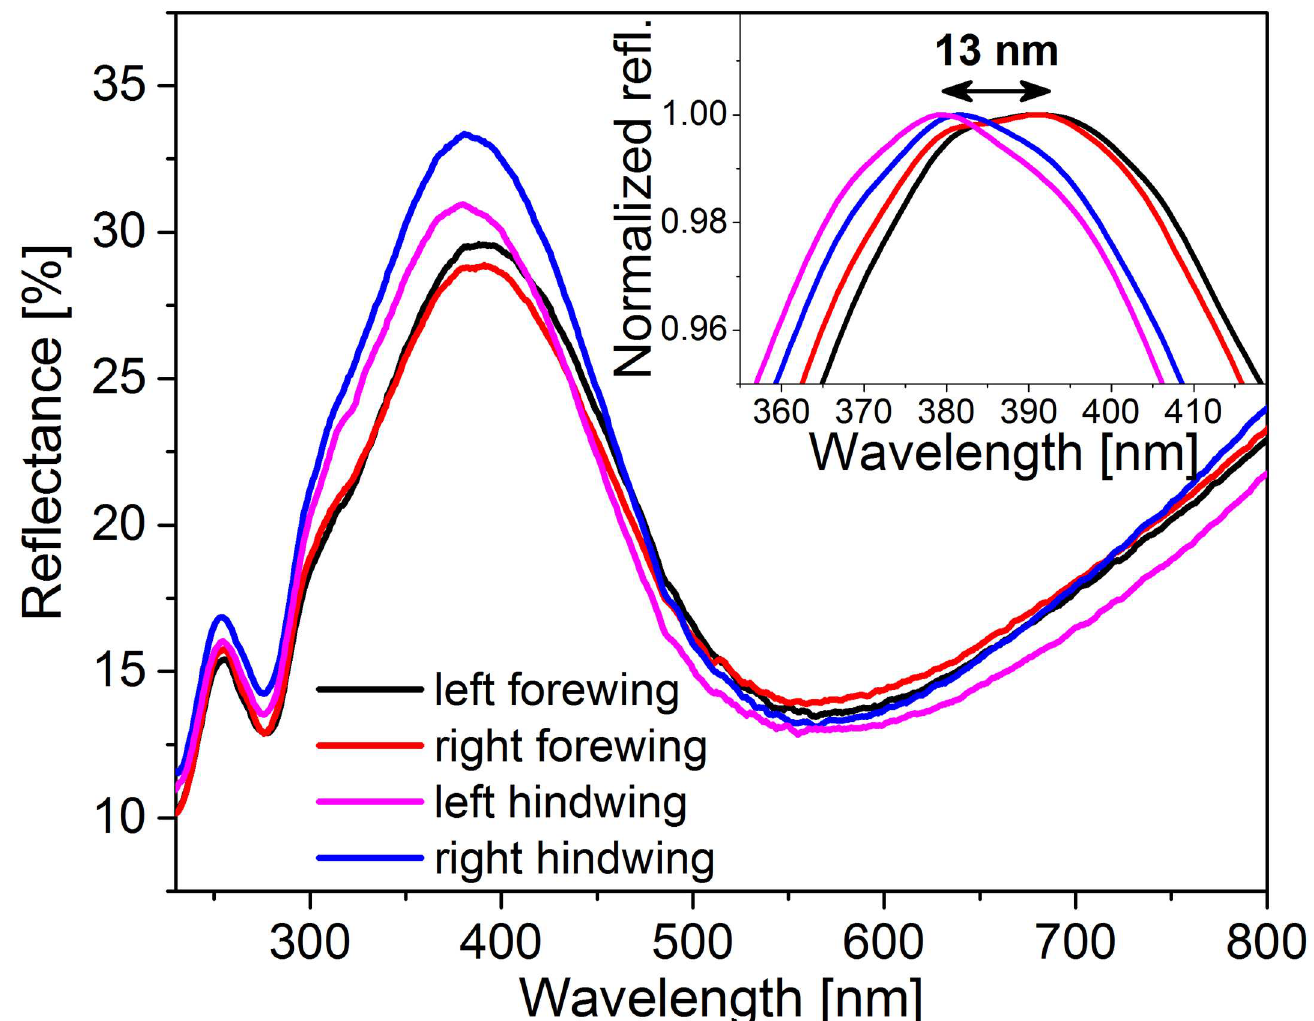
Fig 4. Comparison of the reflectance curves measuredon the four wings of a male P . icarus butterfly using the integrating sphere. The inset in the upper right corner shows the spectral differences in the positionof the normalized